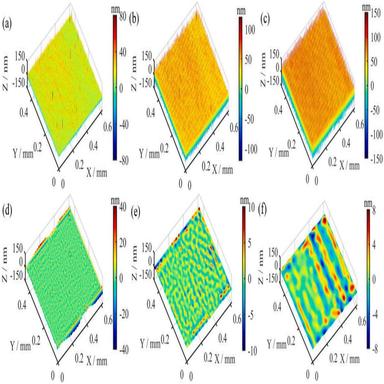
(a–f) are the surface texture within the 1st to the 6th scales at the machining condition I of, respectively.